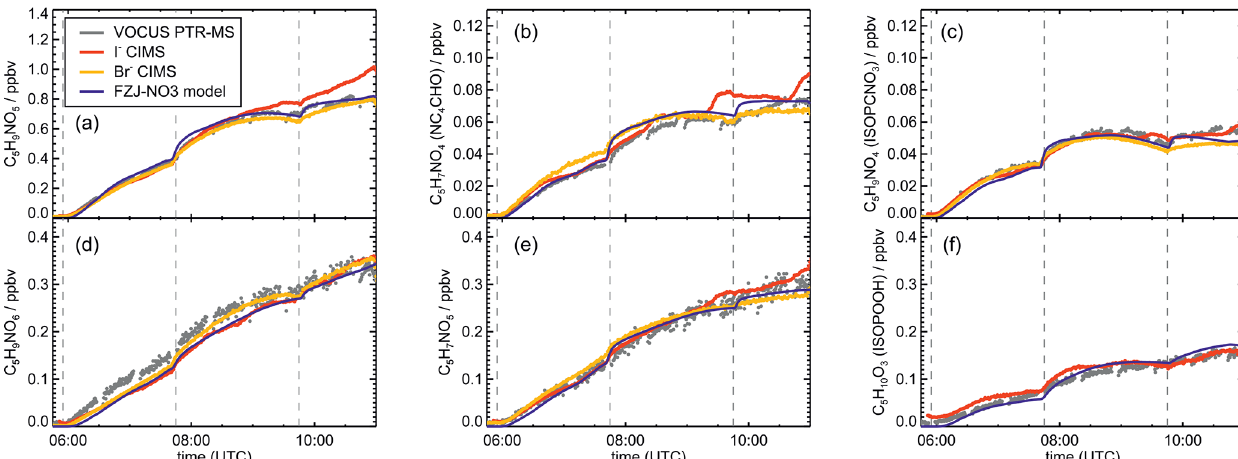
Figure A9. Comparison of reported signals from three mass spectrometer instruments applying different ionization methods (Vocus PTR- MS, Br − CIMS, I − CIMS) and measuring organic products in the experiment on 12 August 2018 (Experiment 3). All signals are scaled to match best the concentrations resulting from model calculations applying the FZJ-NO3 chemical